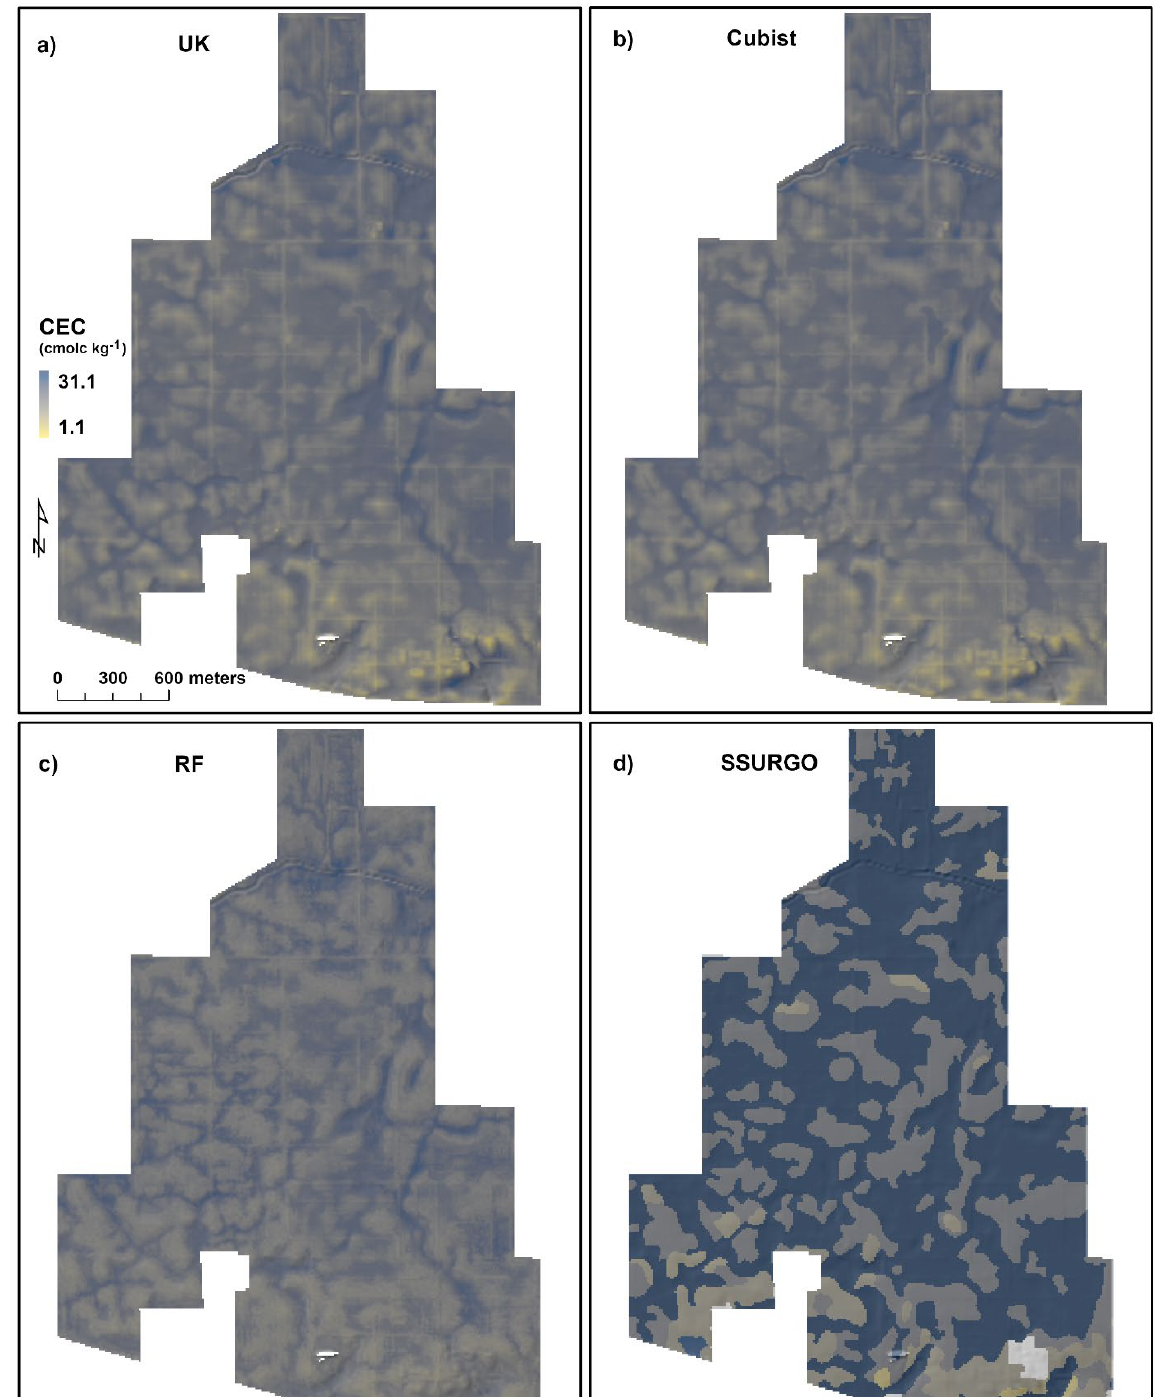
Figure 8. Cation exchange capacity (CEC) prediction. ( a ) Universal kriging (UK), ( b ) Cubist, ( c ) random forest (RF), and ( d ) soil survey geographic (SSURGO). ( c ) random forest (RF), and ( d ) soil survey geographic